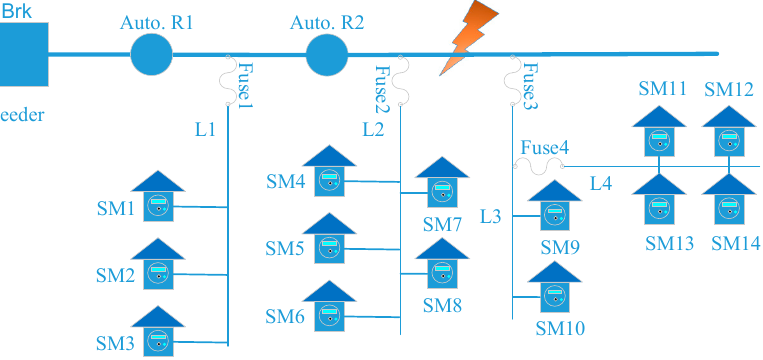
Figure 3. Configuration of a simple distribution system.